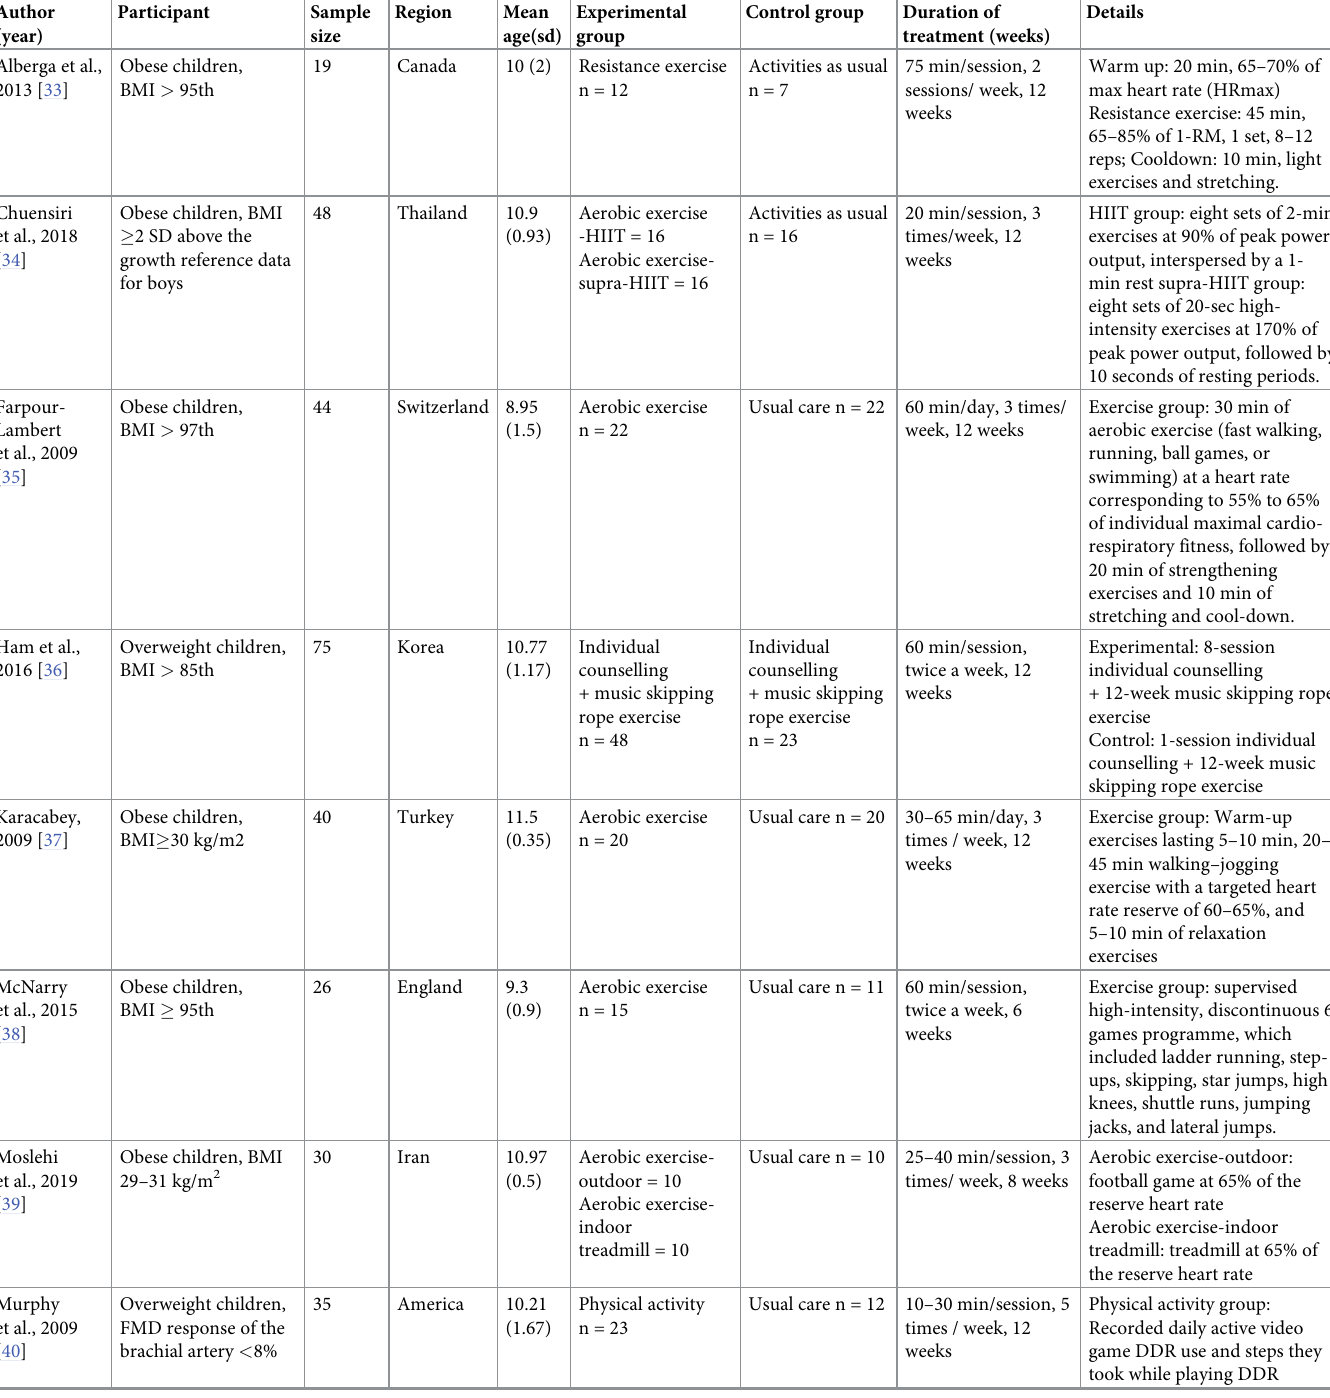
Table 2. Characteristics of the 13 studies included in the systematic